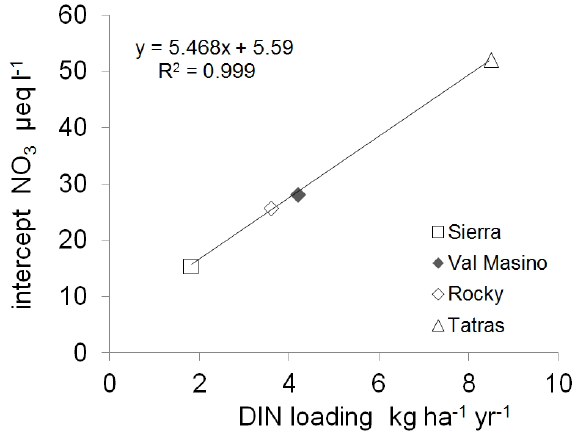
Fig. 9. Relationship between the intercepts of the equations reported in Fig. 8 (NO 3 -N concentration expected for basins without soil cover) and DIN deposition loading measured at Val Masino (present study), the Sierra Nevada, the Rocky Mountains (Sickman et al., 2002) and the Tatra Mountains (Kopacek et al., 2005).